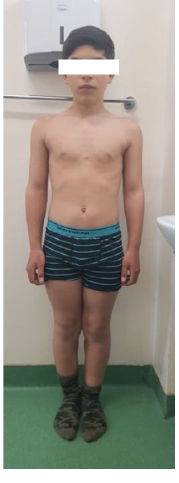
Figure 1. Case report 1 with mesomelic short stature: height − 2.64 SD, BMI at 77th percentile, MPH − 2.14 SD, extremities/trunk ratio ≤ 2.64, and sitting height/height >2.5 SD). The genetic test confirms the SHOX gene mutation. confirms the SHOX gene